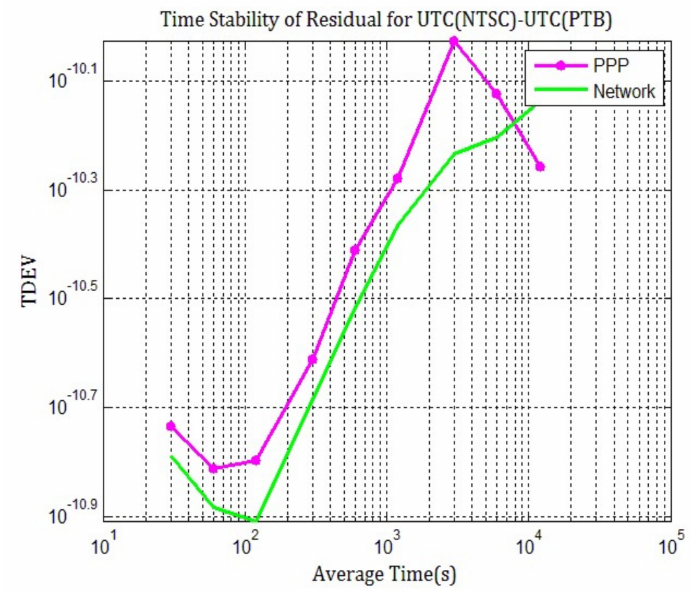
Figure 8. TDEV results for the double-di ff erence of TAIPP with respect to daily PPP (purple), and network solution (green), from MJD 58624 to